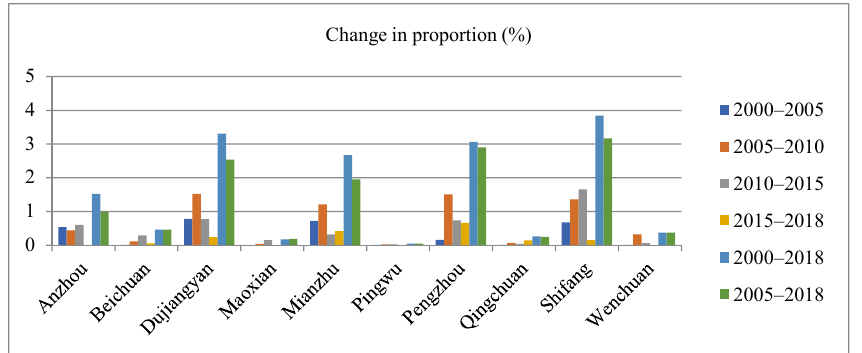
Figure 5. Statistics on urban characteristics change from 2000 to 2018 (county).